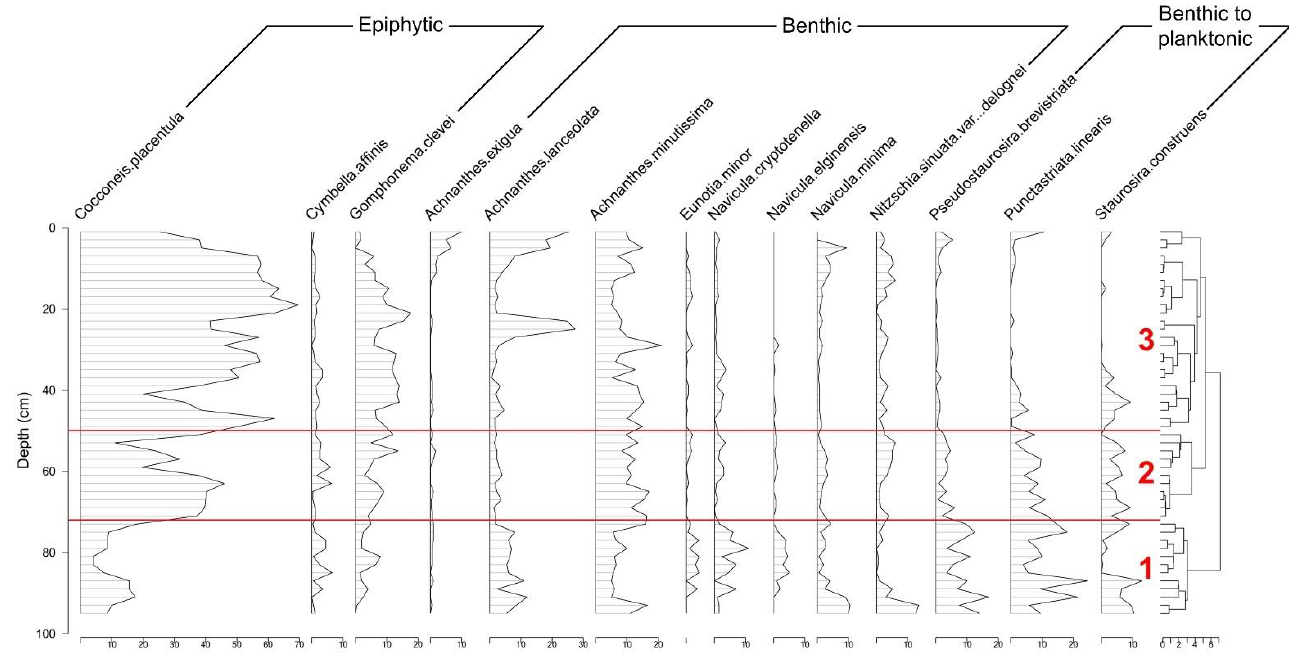
Figure 4. Sediment profile of selected dominant diatom species, stratified into three diatom zones.